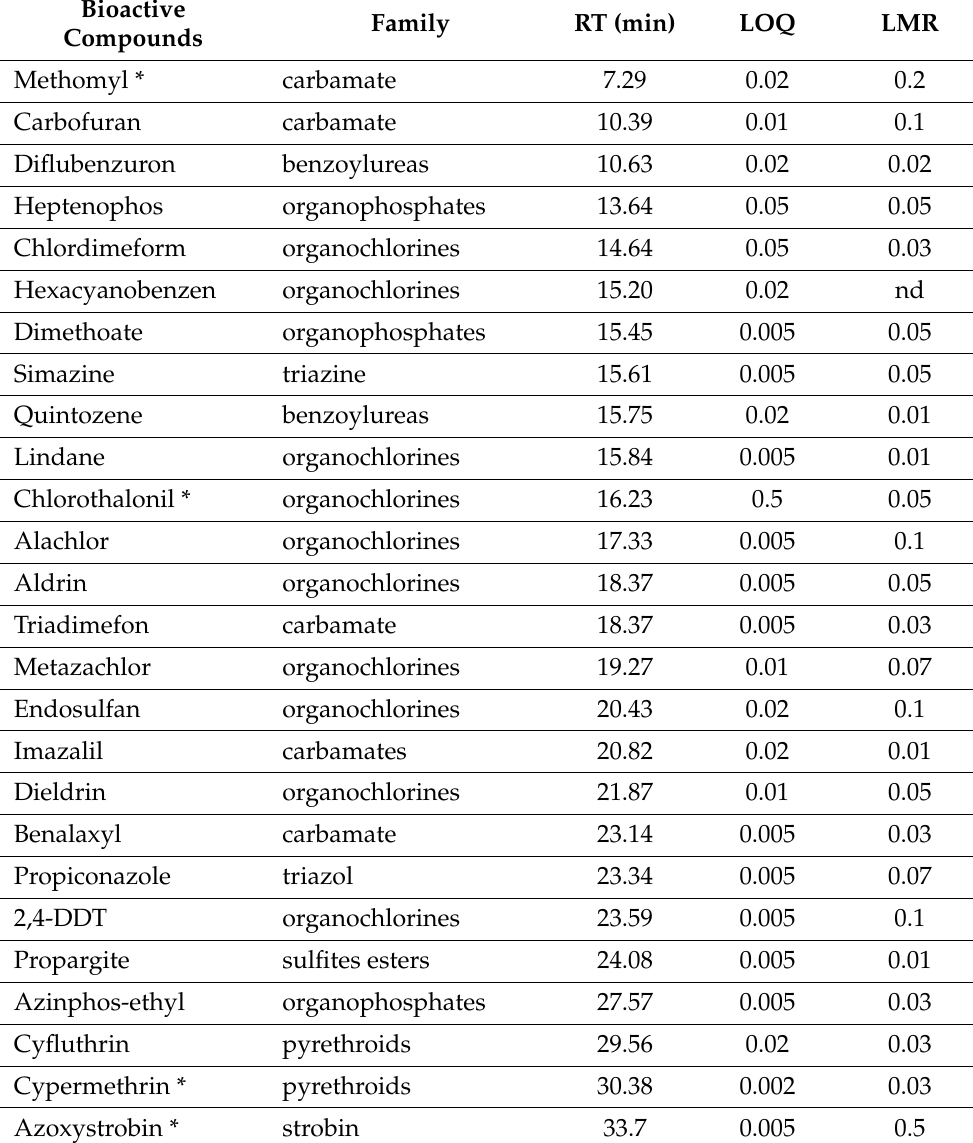
Table 2. Targeted pesticide residues in the two soybean